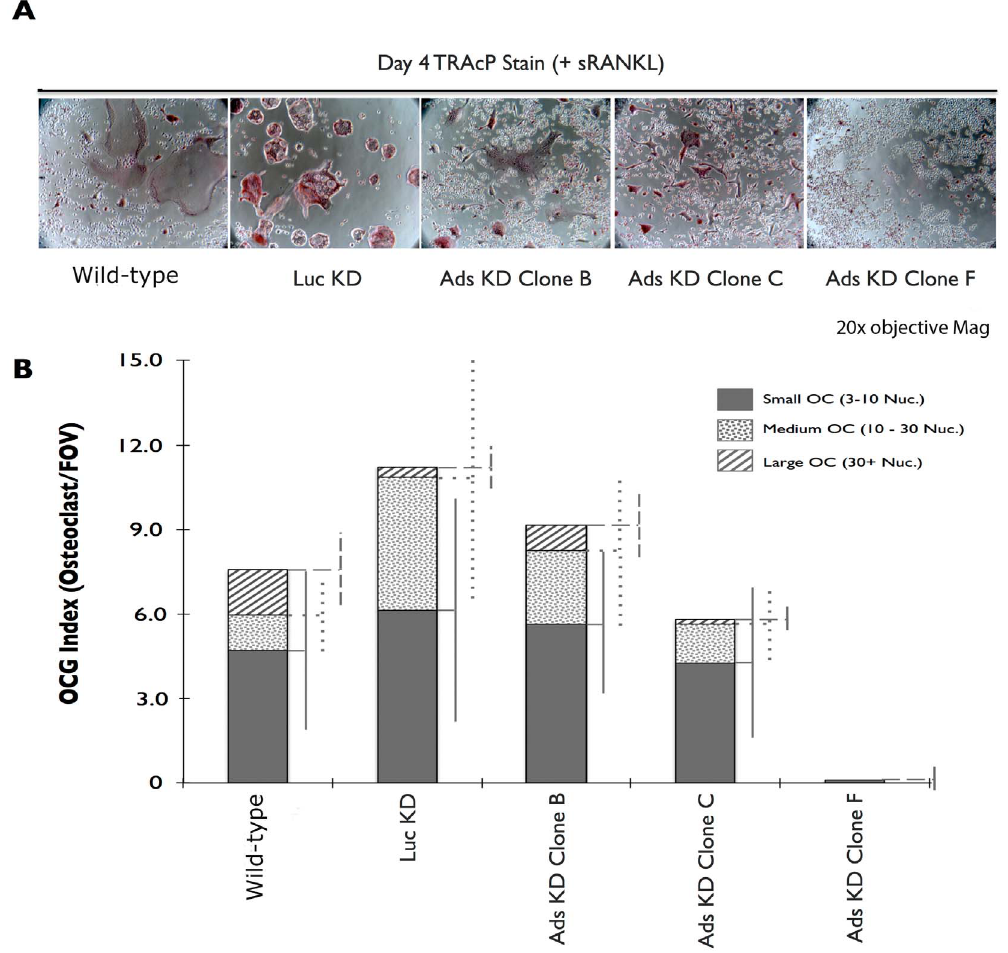
Figure 5. Adseverin knockdown Clone F displayed the greatest defect in osteoclast formation. A ) 2.5 6 10 5 RAW macrophages were seeded onto 6-well tissue culture plates and stimulated for 4 days with sRANKL. Representative photomicrographs of TRAcP stained osteoclasts were taken at 20 6 objective magnification. A profound lack of osteoclasts was observed in Ads KD Clone F. B ) The number of osteoclasts per random field of view (OCG index) was quantified. The number of osteoclasts is represented as three distinct populations of small (3–10 nuclei/osteoclast, solid grey column), medium (5–7 nuclei/osteoclast, dotted column) and large (30 + nuclei/osteoclast, dashed column) osteoclasts (n $ 10). Ads KD Clones B and C experienced marginal and statically non-significant reductions in the number of large osteoclasts when compared to WT cultures. No statistically significant difference in OCG was observed between the WT and Luc KD cultures. Ads KD Clone F macrophages failed for form multinucleated